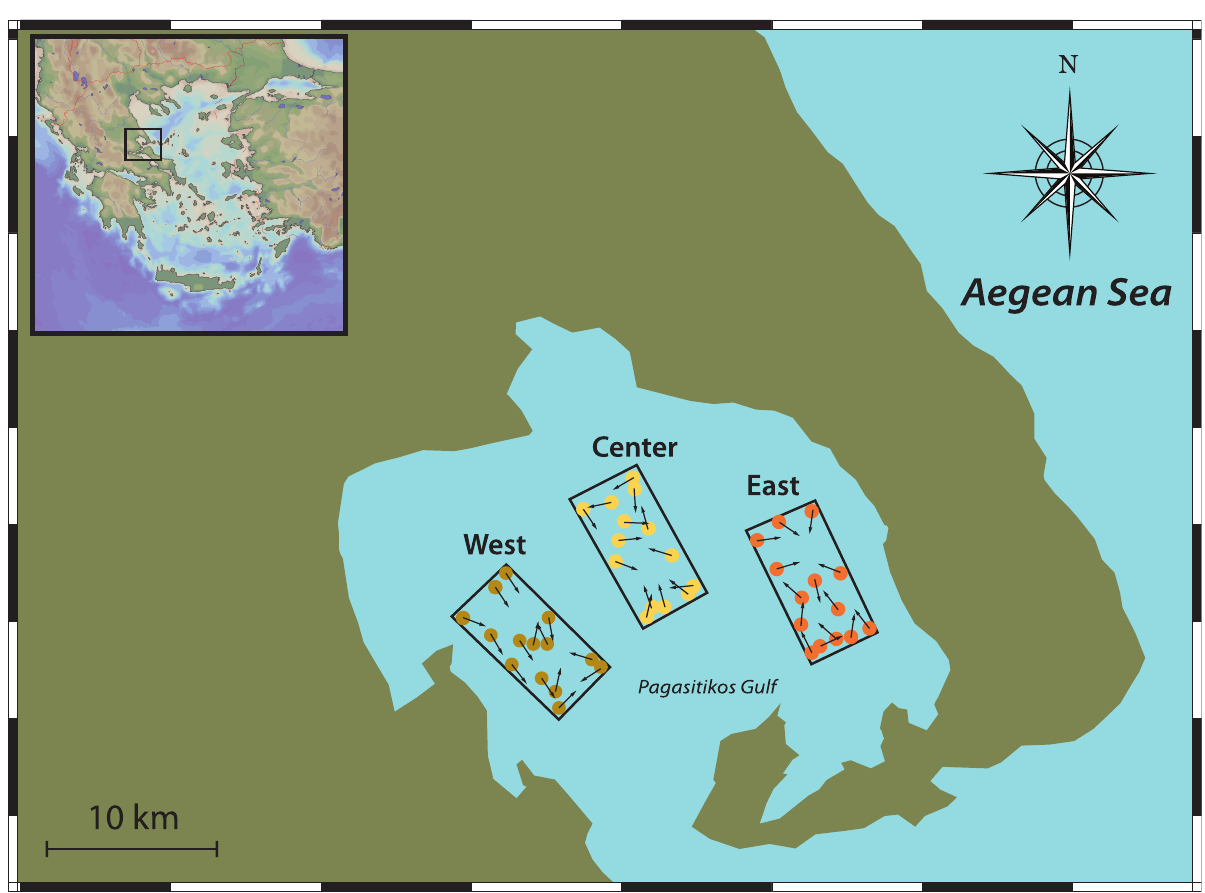
Figure 1. Map of the study area of Pagasitikos gulf, with the three distinct sampling quadrants and sampling locations. Dots indicate the starting position of the haul and vectors indicate the bearing.